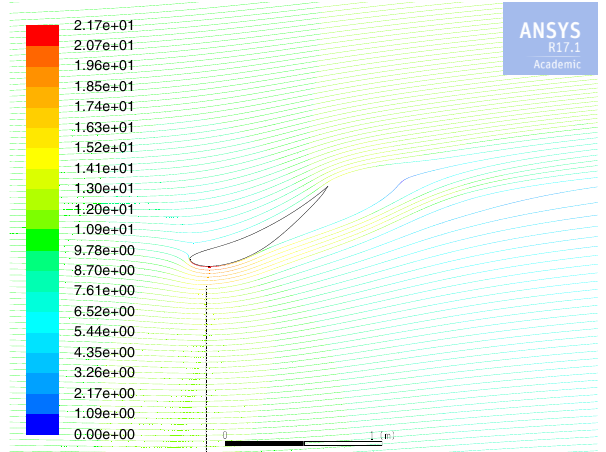
Figure 11. Flow field of a near-optimal design based on C P , total .